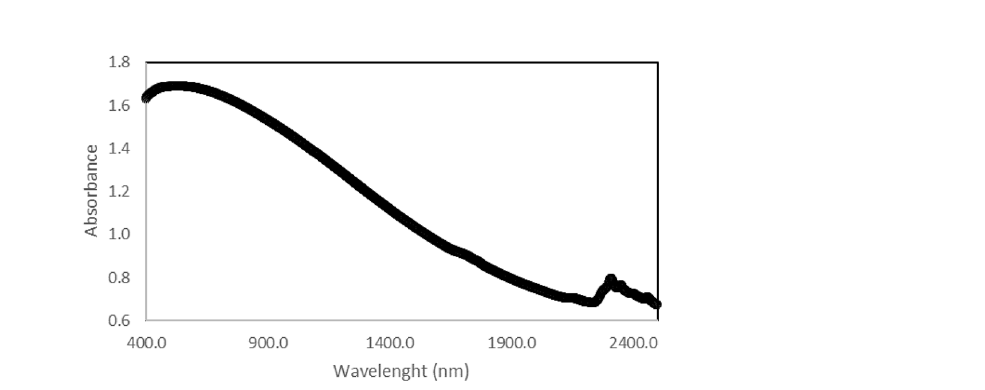
Figure 3. NIR analysis of asphaltene extracted from the tested oil.